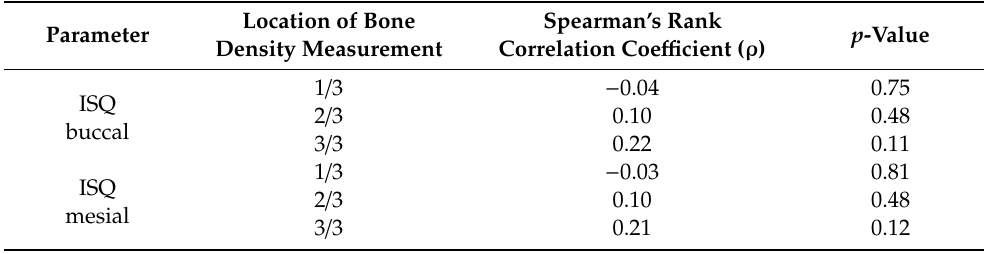
Table 8. Association between primary stability and radiologically measured bone density as a function of the measurement